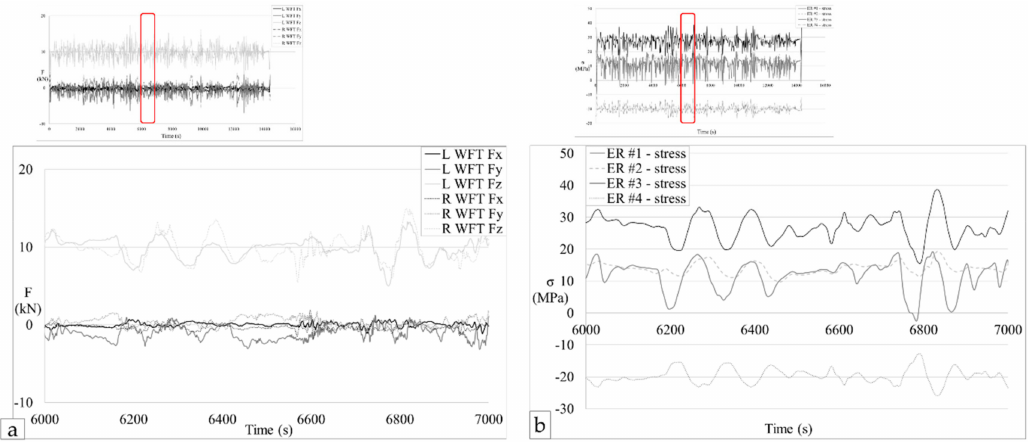
Figure 12. Time frame of load at wheel ( a ) and strain guage outputs ( b ) for the highway mission.